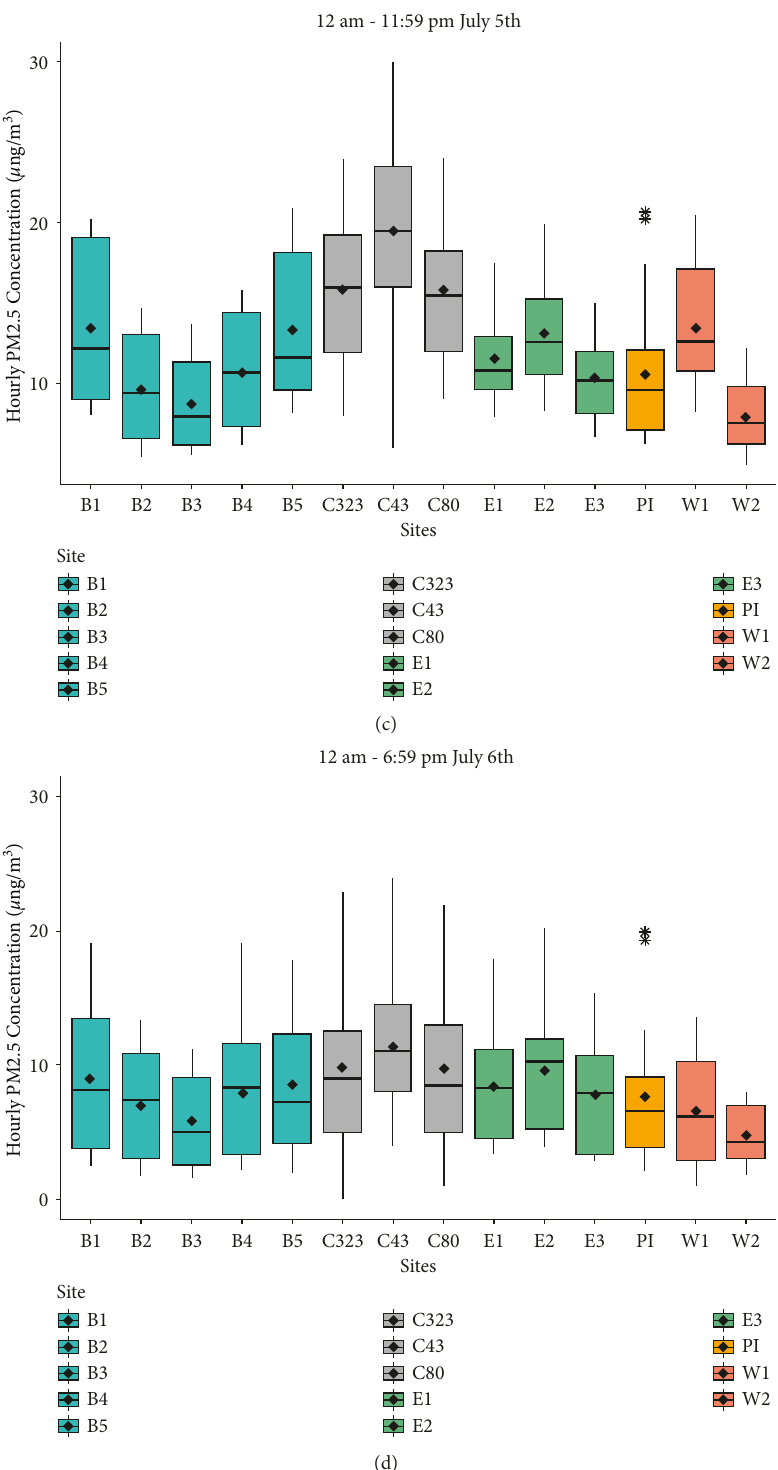
Figure 3: Box plots of hourly average concentrations of PM 2.5 ( µ g/m3) from the study locations and the three CAMS robustly correlated with r > 0.9. On similar lines, sites W1 indicate a lower coefficient. All the site pairings yielded a and W2 were correlated with each other ( r � 0.77). The Port statistically significant and positive correlations. Across the Isabel site was positively correlated with all the sites city of Brownsville, all the sites were very strongly correlated exhibiting a very strong relationship with site (B1, r � 0.84) with r > 0.8. Similarly, the three Edinburg sites were very